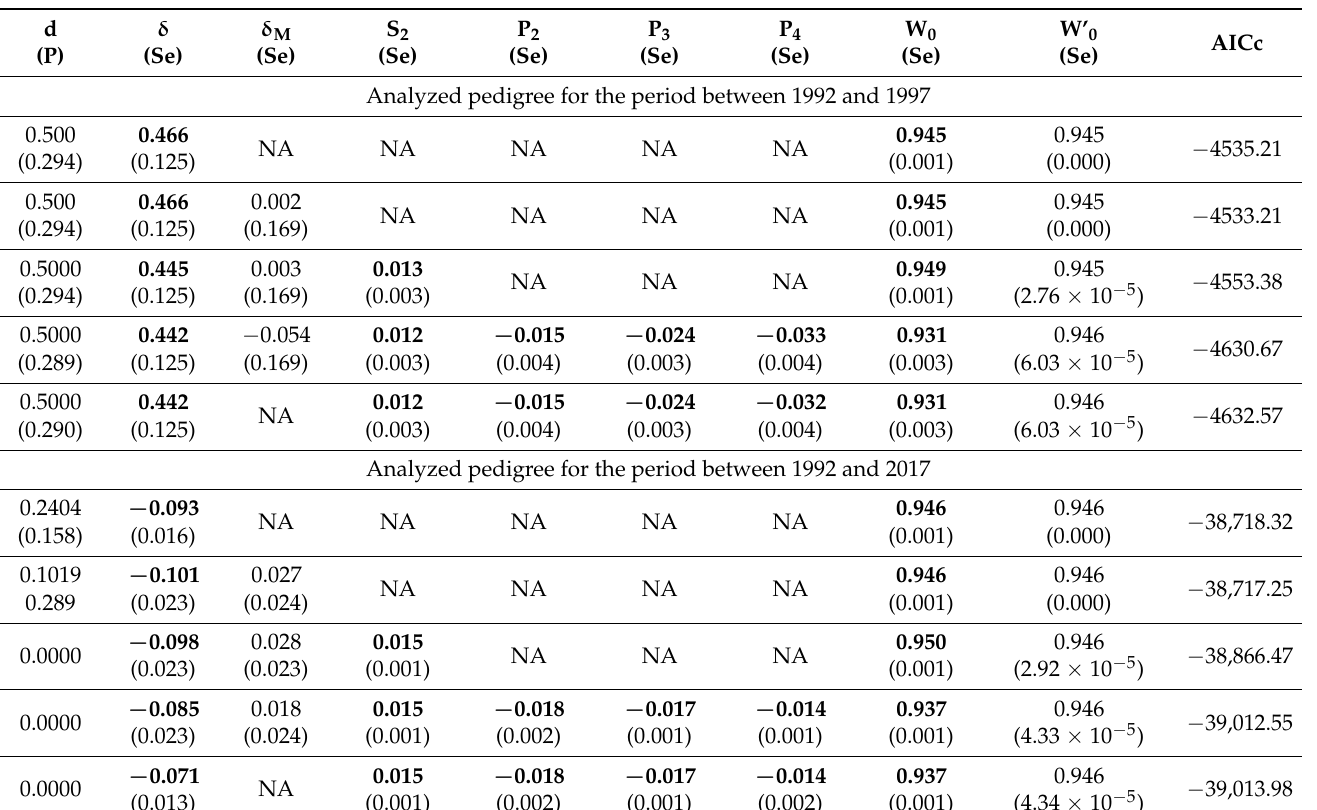
Table 1. Inbreeding-purging parameters estimated for survival of kits at birth in two analyzed